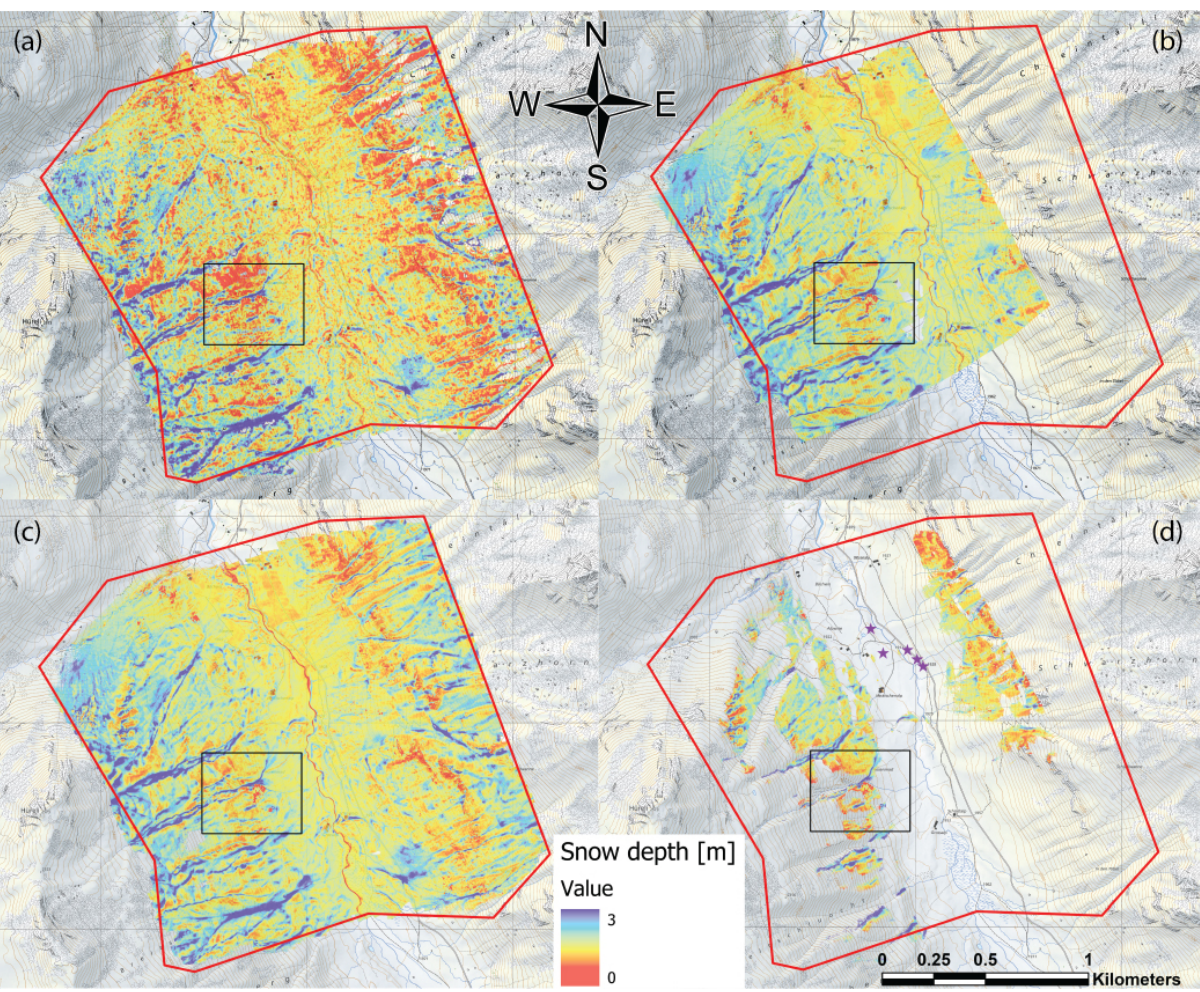
Figure 5. Snow depth maps of the Schürlialp test site from the satellite (a) , the airplane (b) , the UAS (c) and the terrestrial data (d) . On the terrestrial snow depth map, the camera positions are indicated with violet stars. The red polygon depicts the extent of the Schürlialp test site. The black box indicates the zoomed inset shown in Fig. 6 (Swiss Map Raster, source: Federal Office of Topography; Pléiades data © CNES 2018, Distribution Airbus